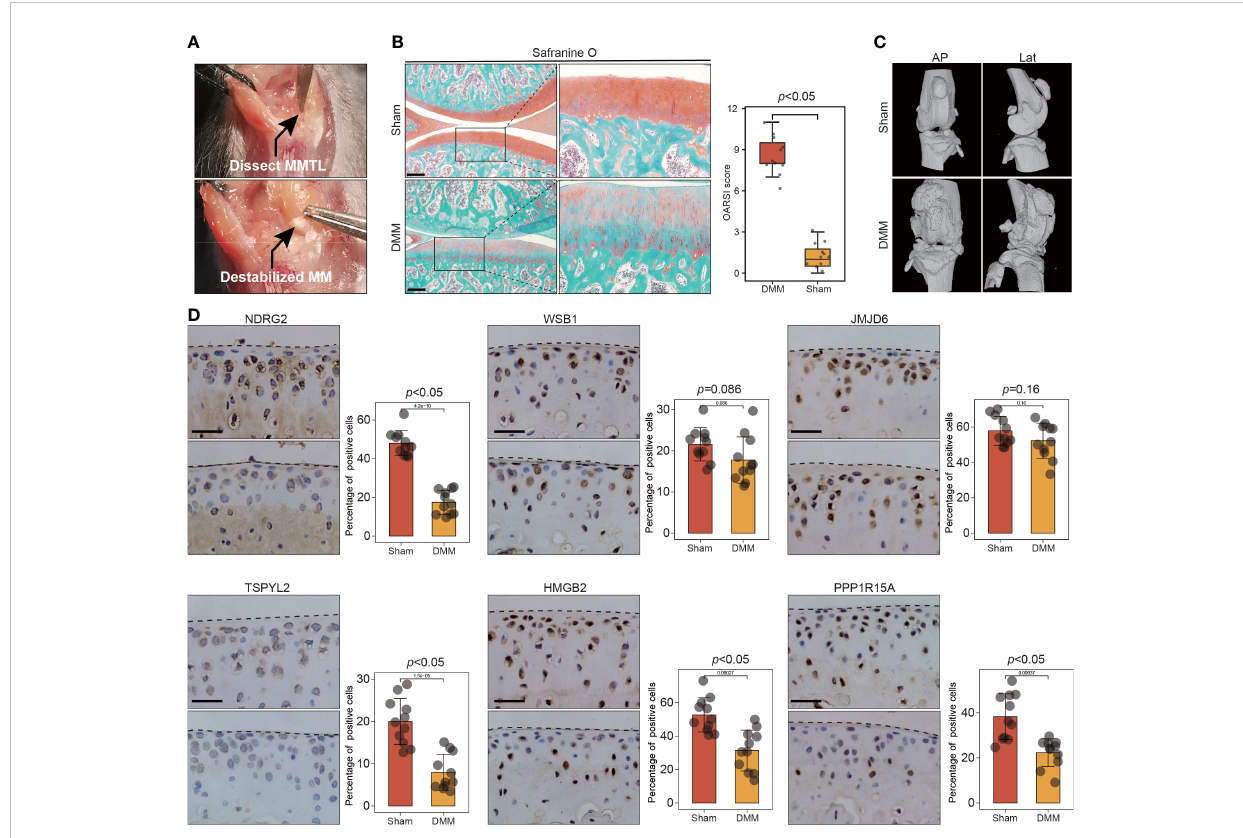
FIGURE 6 The expression of key leading-edge proteins in the DMM induced mouse model of OA. (A) Surgical approach to the right mouse knee joint with transection of the medial meniscotibial ligament. (B) Cartilage destruction was determined by safranin O staining and evaluated by OARSI grade. (C) representative three-dimensional (3D) reconstruction images of mouse knee joints showing abnormal growth of osteophytes.(n=11 per group). (D) Representative images of immunohistochemical staining with antibodies against NDRG2, WSB1, JMJD6, TSPYL2, HMGB2 and PPP1R15A in sham and DMM mouse model of OA. The right panels show the quanti fi cation of the immunohistochemical staining. The scale bar represents 50 m m. MMLT, medial meniscotibial ligament; DMM, destabilization of the medial meniscus; Sham, sham surgery group; AP, Anteroposterior; Lat, lateral. OARSI grade data are expressed as the interquartile range (from the 25th to the 75th percentiles), with the centerline corresponding to the median. IHC quanti fi cation data are expressed as the mean ± SD. Mann – Whitney U test was used for OARSI grade statistical analysis; Student ’ s t test was used for IHC quanti fi cation statistical analysis. p < 0.05 was considered statistically signi fi